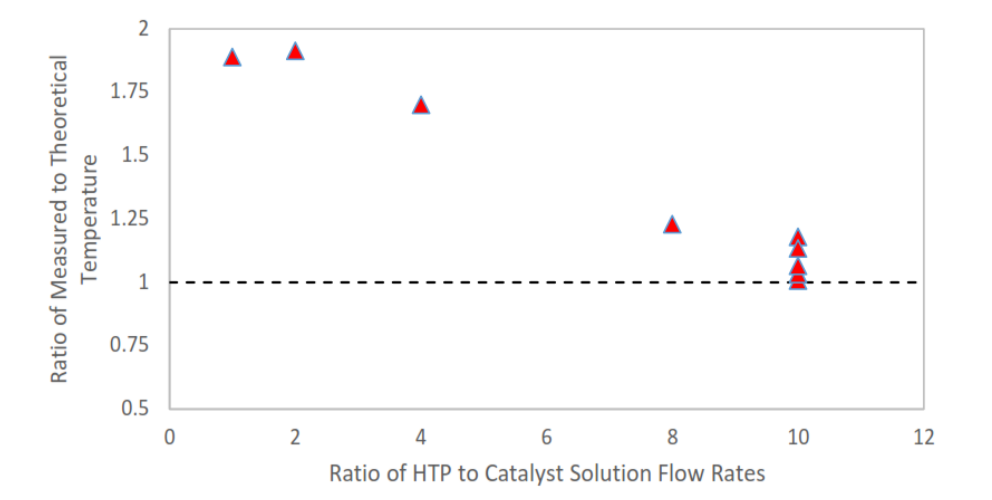
Figure 18. The ratio of measured to theoretical temperature vs. the ratio of volumetric flow rate of HTP to catalyst solution. High ratios of HTP to catalyst solution show agreement with quasi-one-dimensional isentropic supersonic flow in the nozzle. This strongly suggests the flow through the nozzle is choked at the throat at high HTP to catalyst solution ratios.